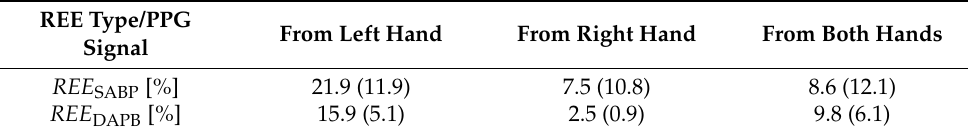
Table 1. Obtained partial mean REE values together with their std (in parentheses) separately cal- culated for the left hand, the right hand, and both hands together; PPG signals sensed from the tested person F1. Table 2. Obtained summary mean REE values together with their std (in parentheses) separately for male/female and all tested persons.